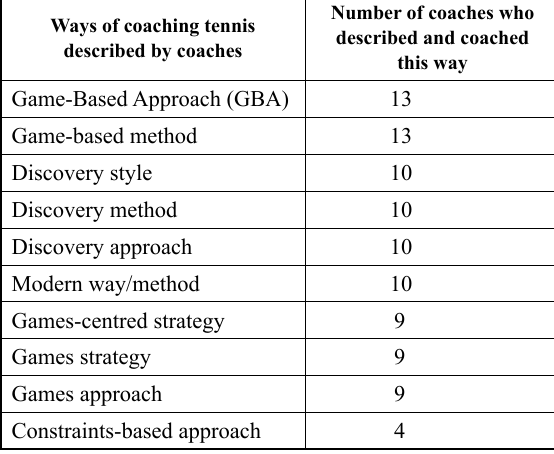
Table 1. Outline of all the terms that the interviewed coaches ( n = 13) described as the ways that they coached during their three observed coaching session Number of coaches who Ways of coaching tennis described and coached described by coaches this way Game-Based Approach (GBA) 13 Game-based